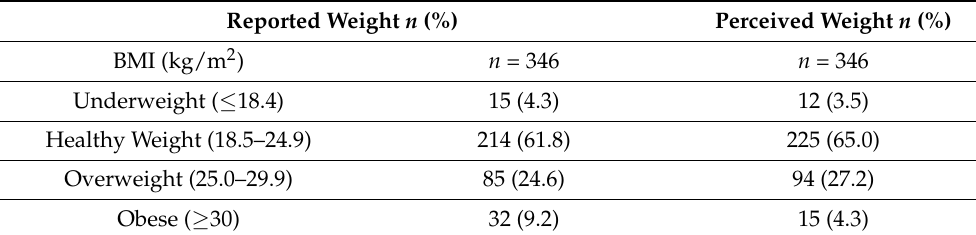
Table 1. Reported and perceived weight status in body mass index